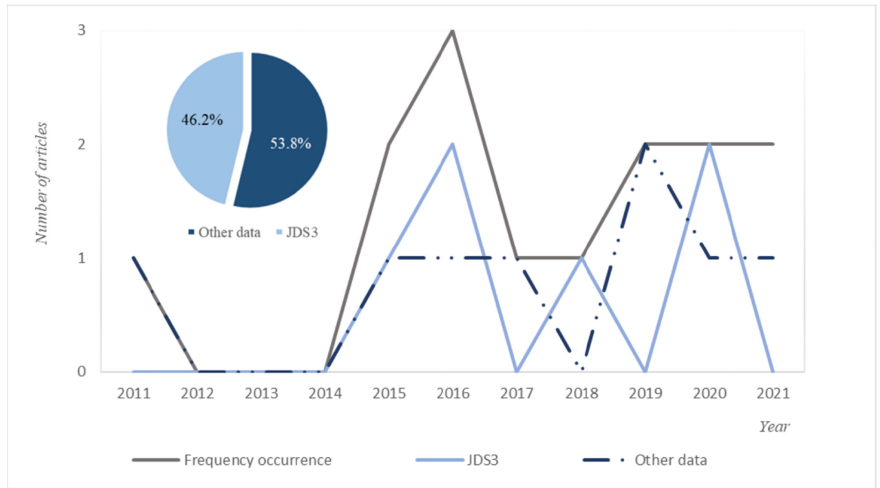
Figure 4. The frequency of paper occurrence in the last decade, and data used.